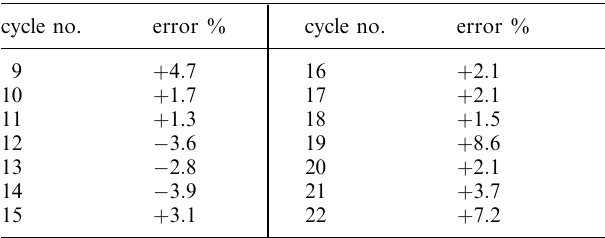
Table 6. Peak projection